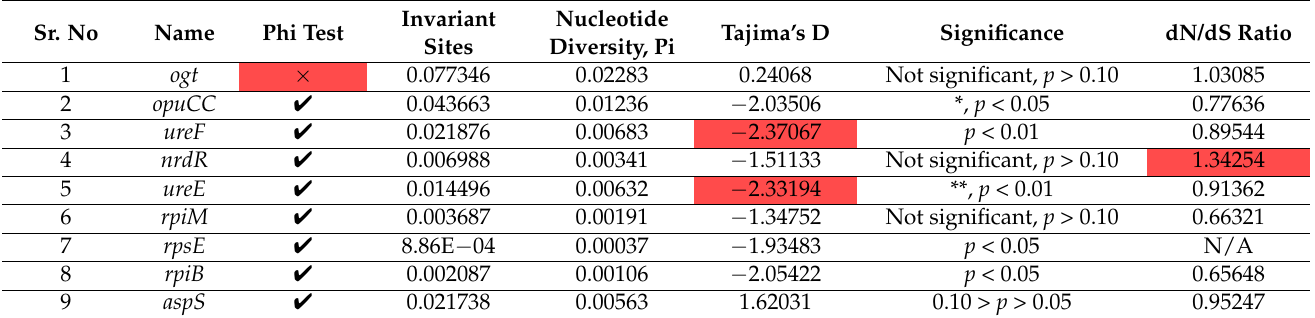
Table 5. Shortlisted gene candidates based on statistically suitable values. The table enlists the nine genes candidates that were shortlisted after determining the statistical values through Phi, Tajima’s, and Fu and Li’s test.